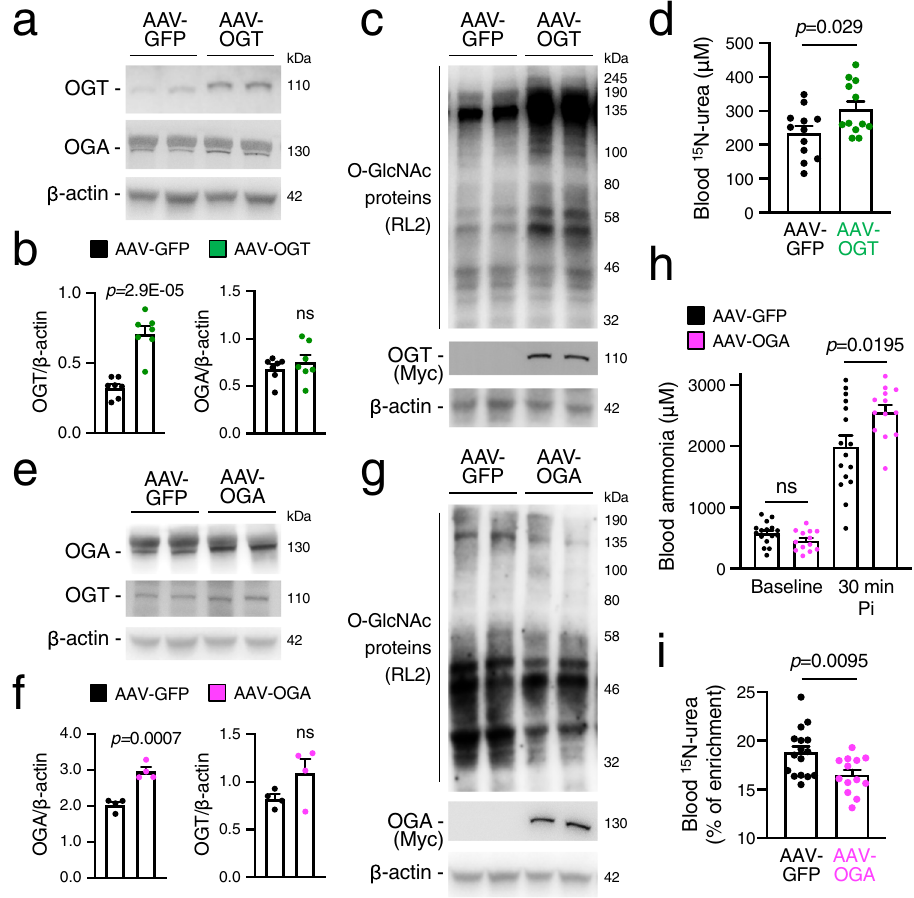
Fig. 2 | Hepaticprotein O-GlcNAcylation regulatesureagenesis. a Westernblots for OGT and OGA of livers of C57BL/6 wild-type (WT) mice harvested four weeks aftertheintravenous(i.v.)injectionsof1×10 13 genomecopies(GC)/kgofAAV-OGT vectorexpressingtheOGTunderthecontrolofaliver-speci fi cpromoteroranAAV- GFP expressing the GFP reporter gene under the control of the same promoter, as controls. b Densitometricquanti fi cations( n =7mice/group). p =2.9E-05(Unpaired t -test). c Westernblot for O-GlcNAcproteins and Myc-taggedOGT in livers of AAV- OGT-andAAV-GFP-injectedWTmice. d 15 N-ureainblood30minafteri.p.injections of 15 NH 4 Cl (2mmol/kg) in AAV-OGT- and AAV-GFP-injected WT mice ( n =12 mice/ group). p =0.029 (Unpaired t -test). e Hepatic OGA and OGT proteins by Western blot in WT mice injected i.v. with AAV-OGA vector (1×10 13 GC/kg) at four weeks